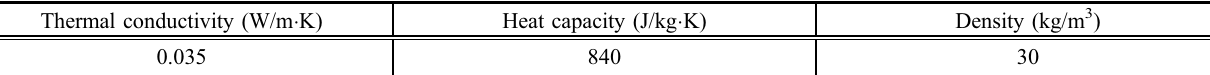
Table 2 Properties of thermal insulation material.